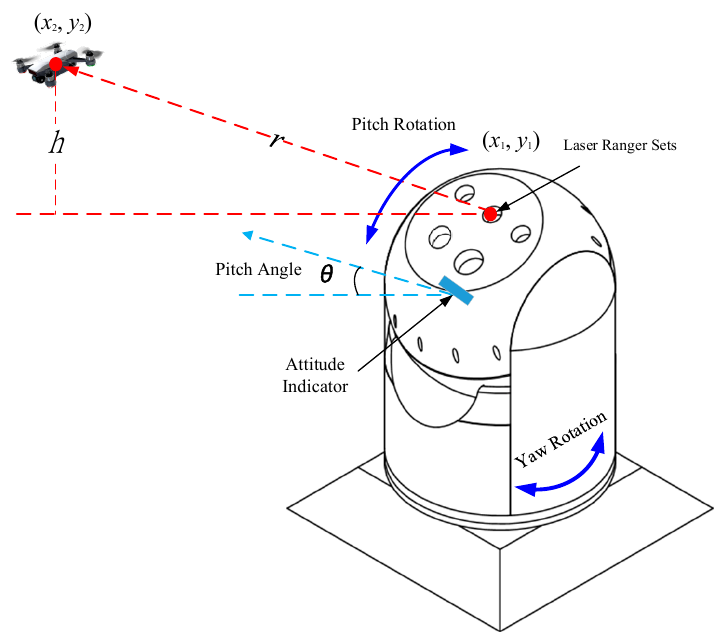
Figure 6. Schematic diagram of the calculation of the height of the drone on the image concentric point by the attitude meter and the laser ranger.